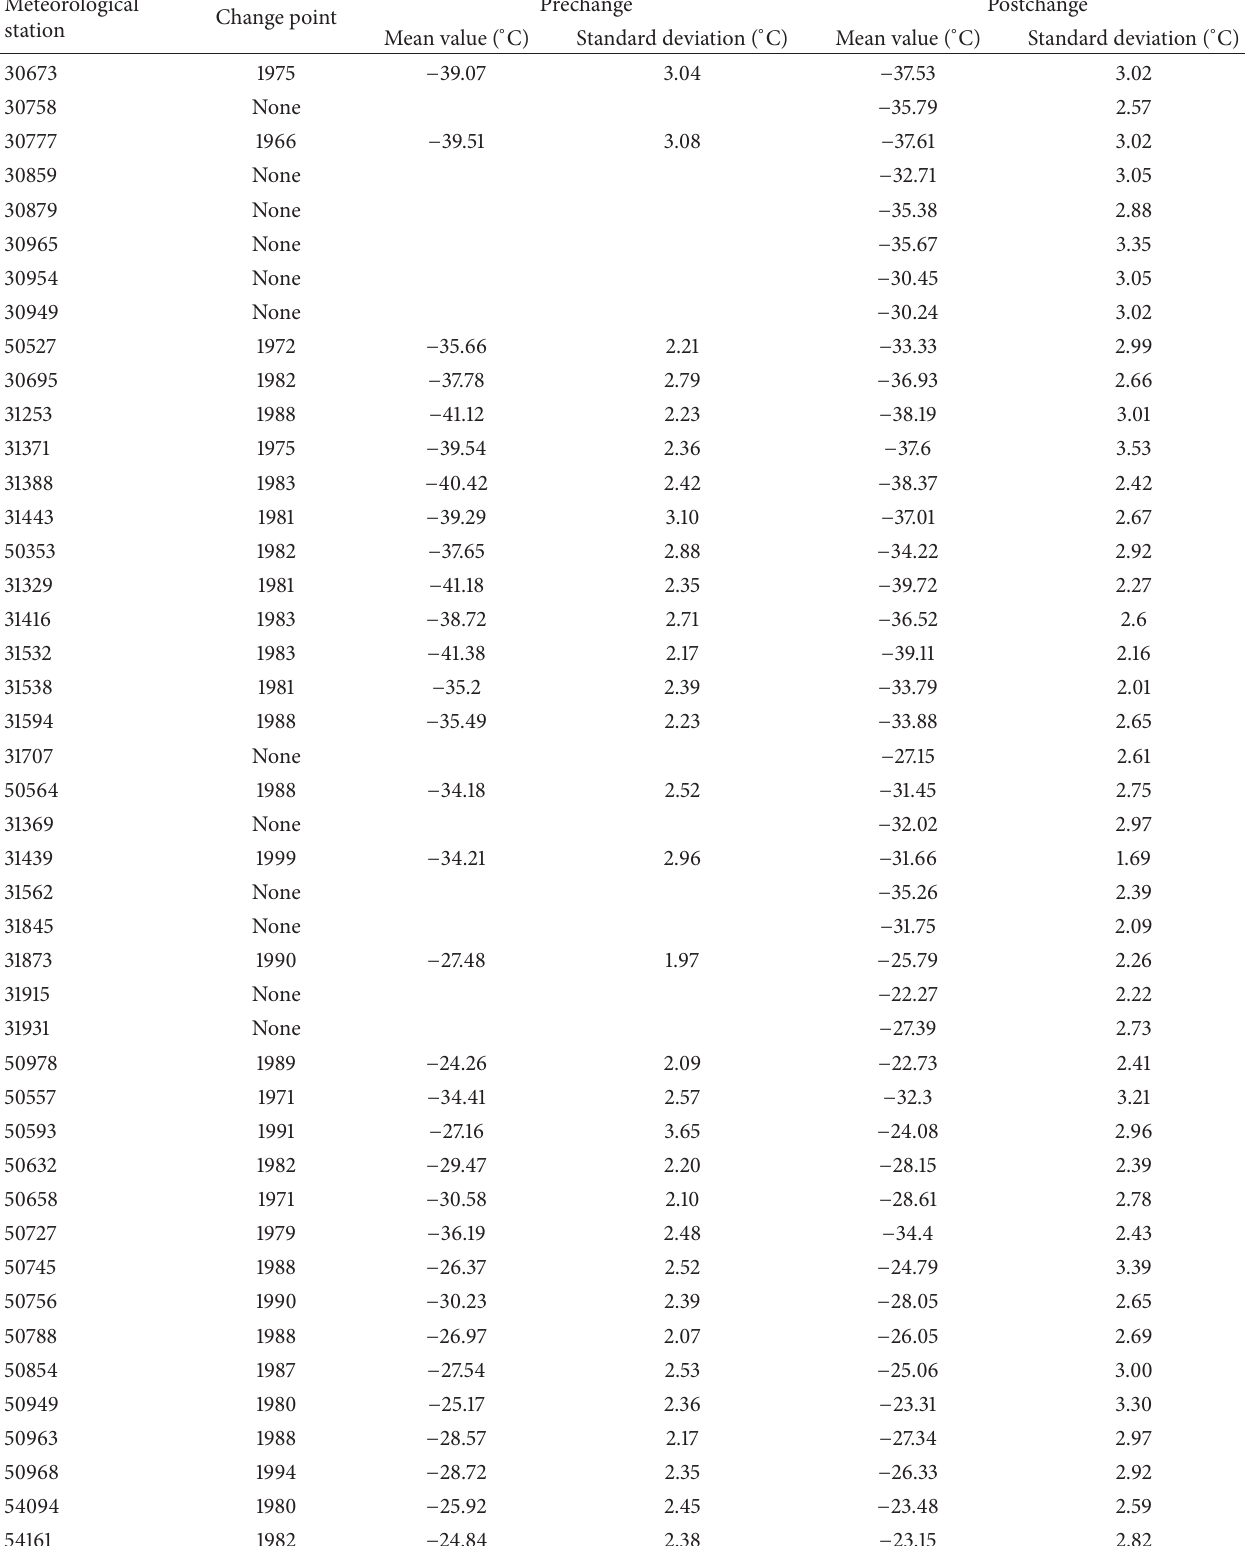
Table 4: Climate change detection and descriptive statistics of the annual minimum temperature